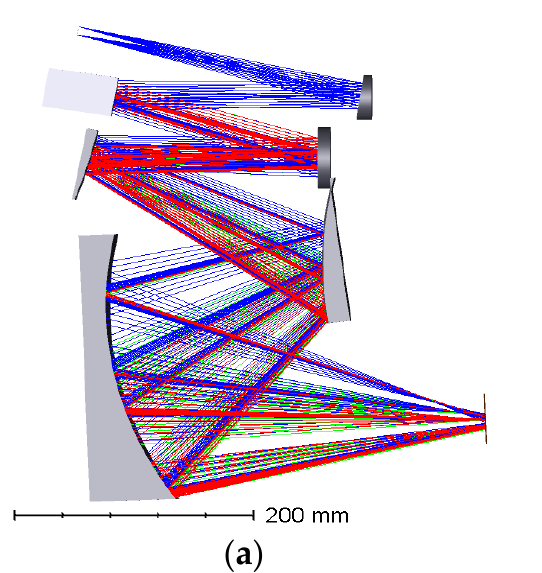
Figure 9. Optical configuration of the echelle spectrometer system: ( a ) Optical System; ( b ) Immersion Grating Simulation Model.